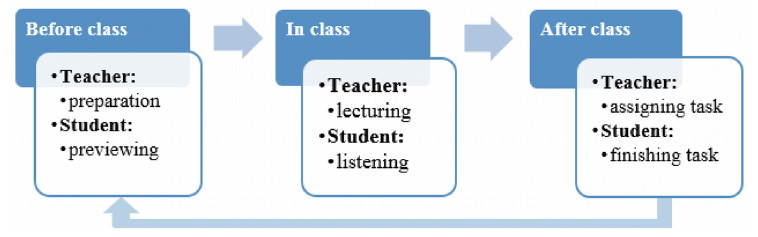
Figure 1. Structural Framework for Face to Face Learning